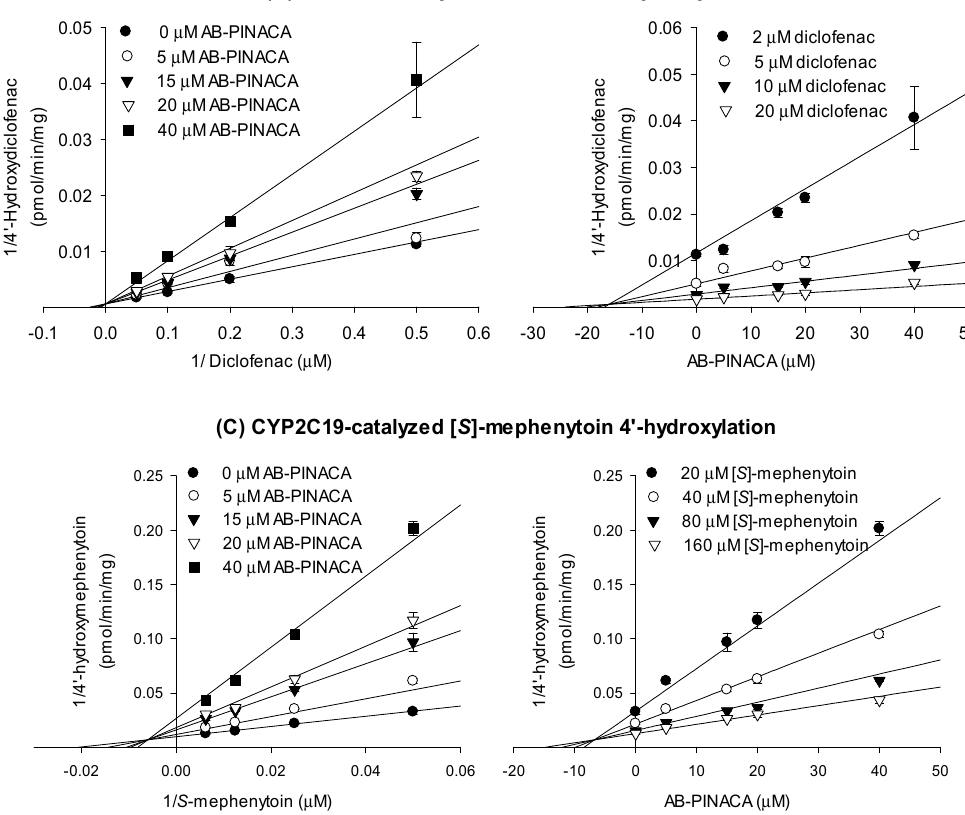
Figure 2. Lineweaver–Burk (left panel) and Dixon (right panel) plots for the inhibitory effects of AB- PINACA (1–40 µM) on ( A ) CYP2C8, ( B ) CYP2C9, and ( C ) CYP2C19 activities in the presence of varying concentrations of substrates, amodiaquine (1, 2, 4, and 8 µM), diclofenac (2, 5, 10, and 20 µM), or [ S ]-mephenytoin (20, 40, 80, and 160 µM) in ultrapooled human liver microsomes. Data are means ± SD ( n = 3).